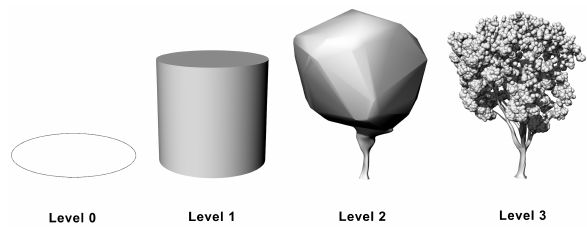
Figure 2. Varying LODs for solitary vegetation